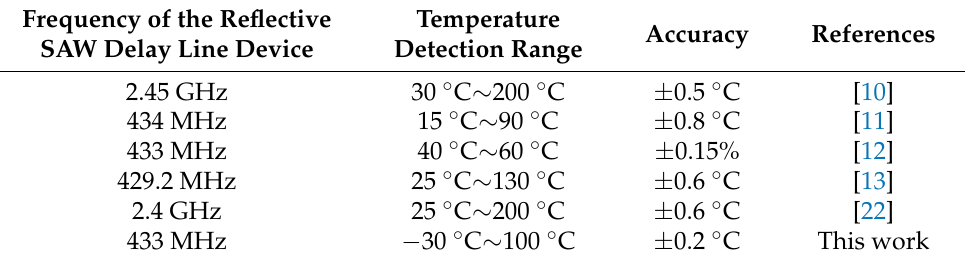
Figure 7. ( a ) The sensitivity evaluation and ( b ) accuracy measurement of the proposed sensor system. Table 2. The accuracy comparison between the proposed sensor with similar